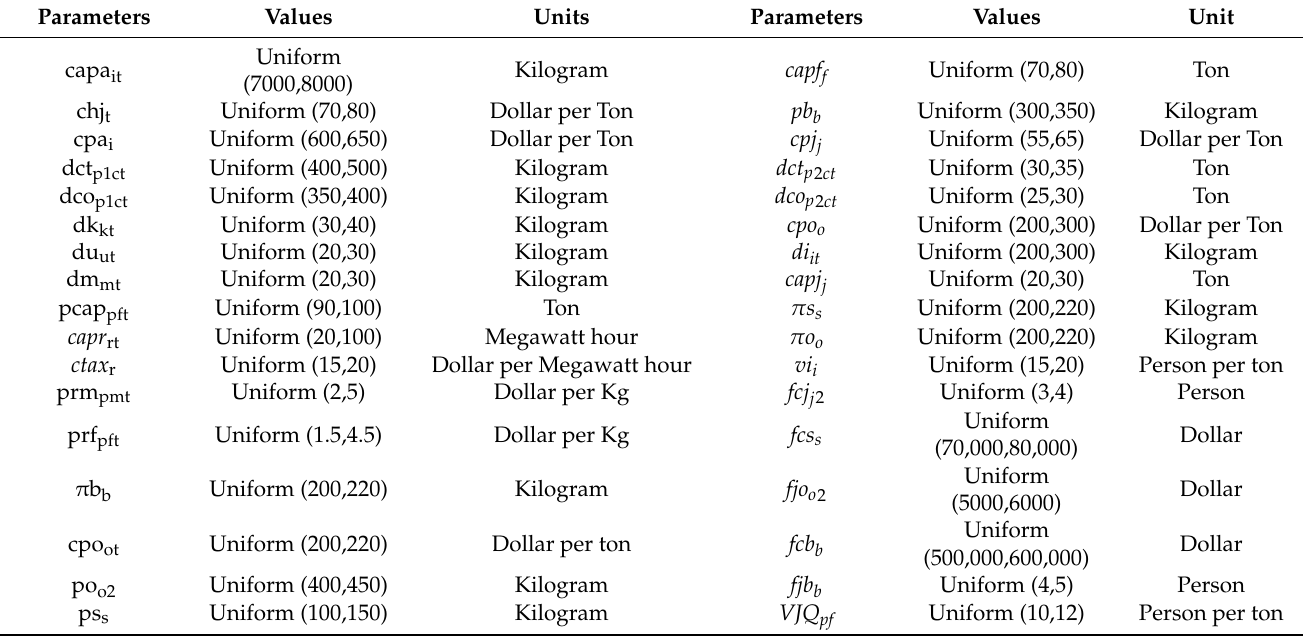
Table A5. Tuning other parameters of model.